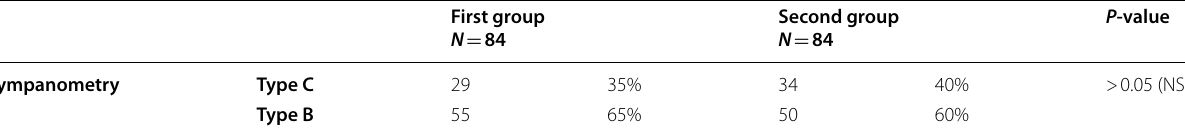
Chi-square test: NS no statistically significant difference